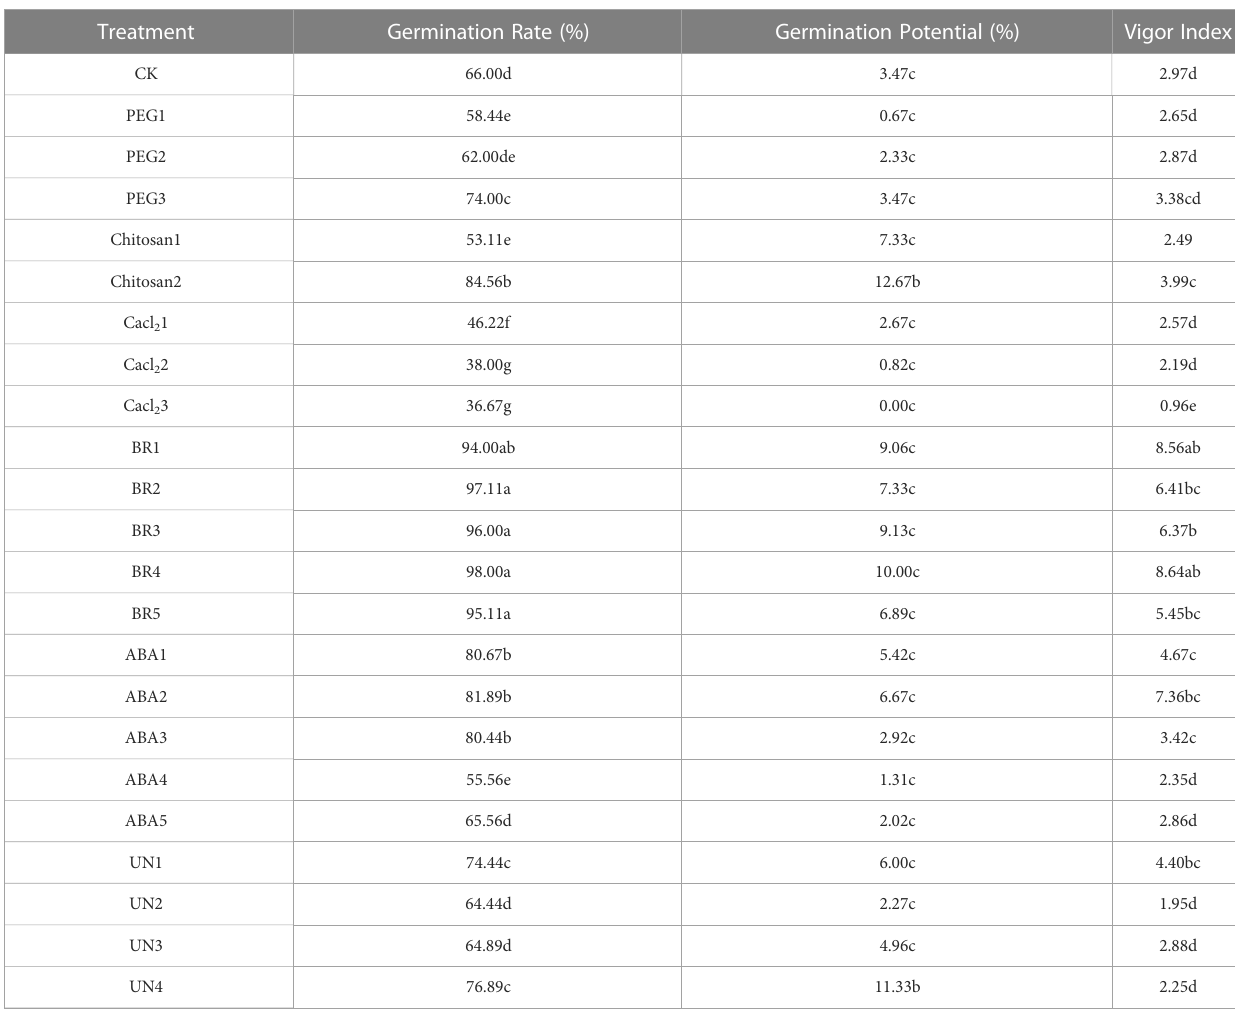
TABLE 2 Changes in germination rates, germination potential, and vigor index of rice seedlings under chilling stress in response to the seed priming treatments.